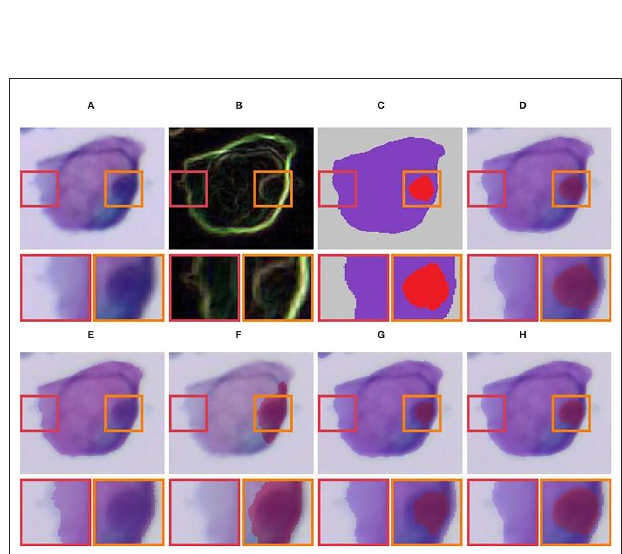
FIGURE 10 | Qualitative comparison of single-cell label correction. (A) Input; (B) Gradient image; (C) Original mask; (D) Input + original mask; (E) Active contours (Chan and Vese, 2001) for cytoplasm; (F) Active contours (Chan and Vese, 2001) for nucleus; (G) Dense CRF (Krähenbühl and Koltun, 2011); (H) Our